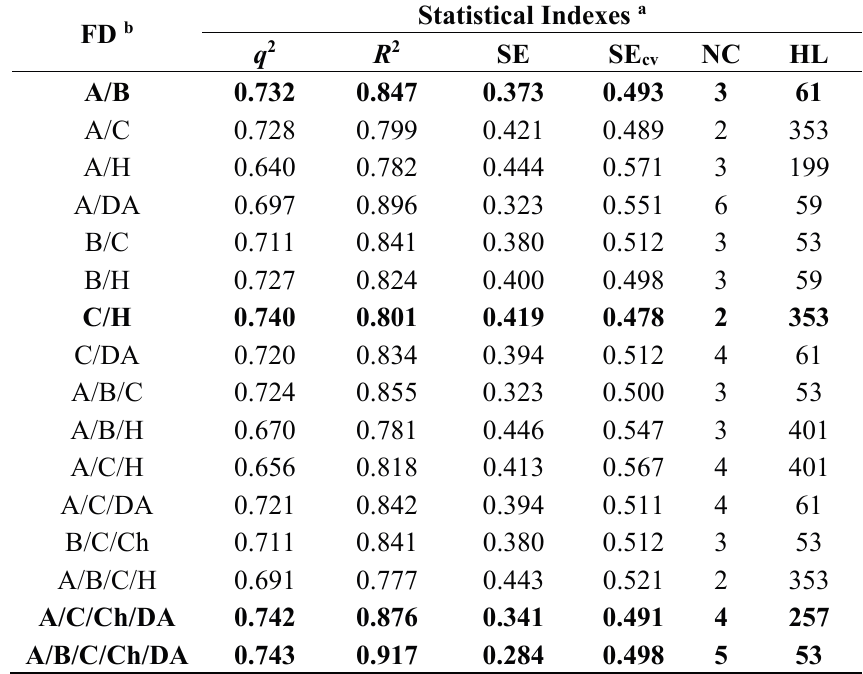
Table 1. Summary of the HQSAR statistical indexes for various fragment distinction (FD) parameters using the default fragment size (4–7 atoms) for the 6-arylquinazolin-4-amine derivatives ( N =